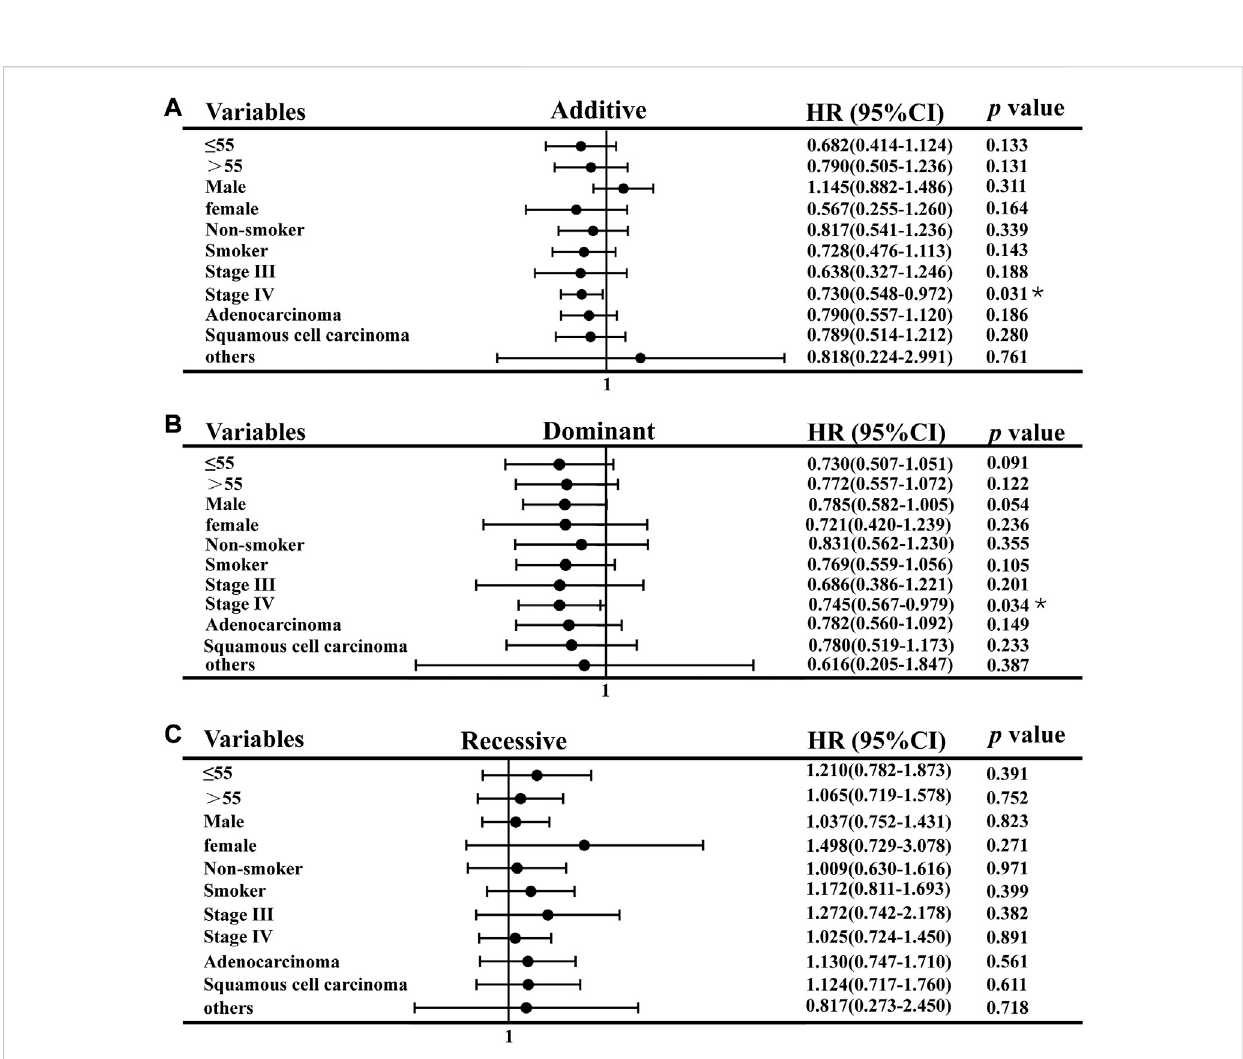
FIGURE 2 Association of CAT rs769217 and PFS in Strati fi cation analyses, (A) additive model, (B) Dominant model, (C) Recessive model. p * < 0.05, p ** <